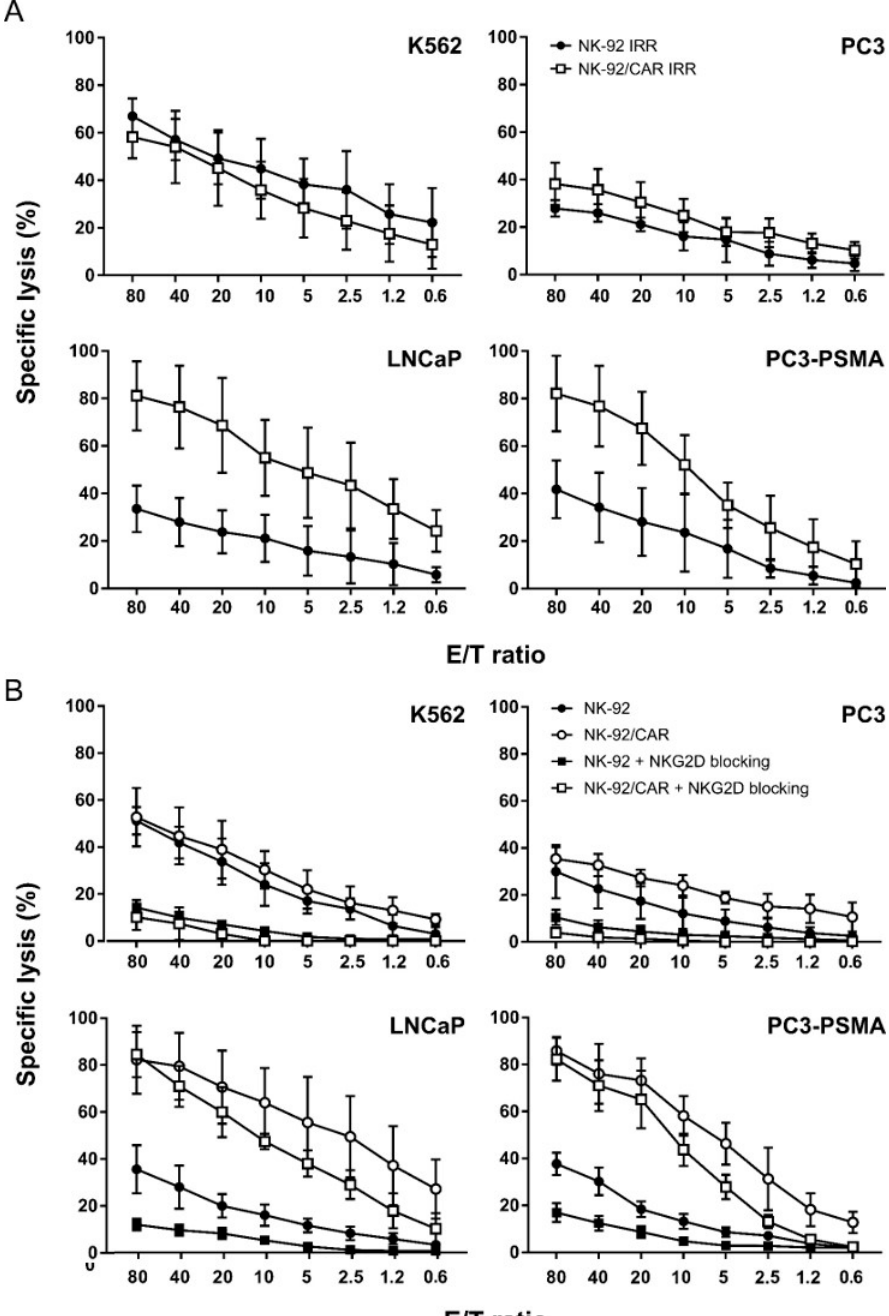
Figure 4. Lytic activity of irradiated NK-92/CAR cells before and after NKG2D blocking. ( A ) Cytotoxicity of 10 Gy-irradiated NK-92/CAR (open squares) and NK-92 (filled circles) cells was investigated against K562, PC3, LNCaP, and PC3-PSMA cells, at different E/T ratios. ( B ) To evaluate the effects of NKG2D blocking, irradiated NK-92/CAR (open squares) and parental NK-92 (filled squares) cells were pre-treated with anti-NKG2D antibody for 1 h before incubation with K562, PC3, LNCaP, and PC3-PSMA targets. Irradiated non-blocked CAR-transduced (open circles) and wild-type (filled circles) effectors were included for comparison. Lysis data are shown as mean values ± SD of 3 independent experiments.